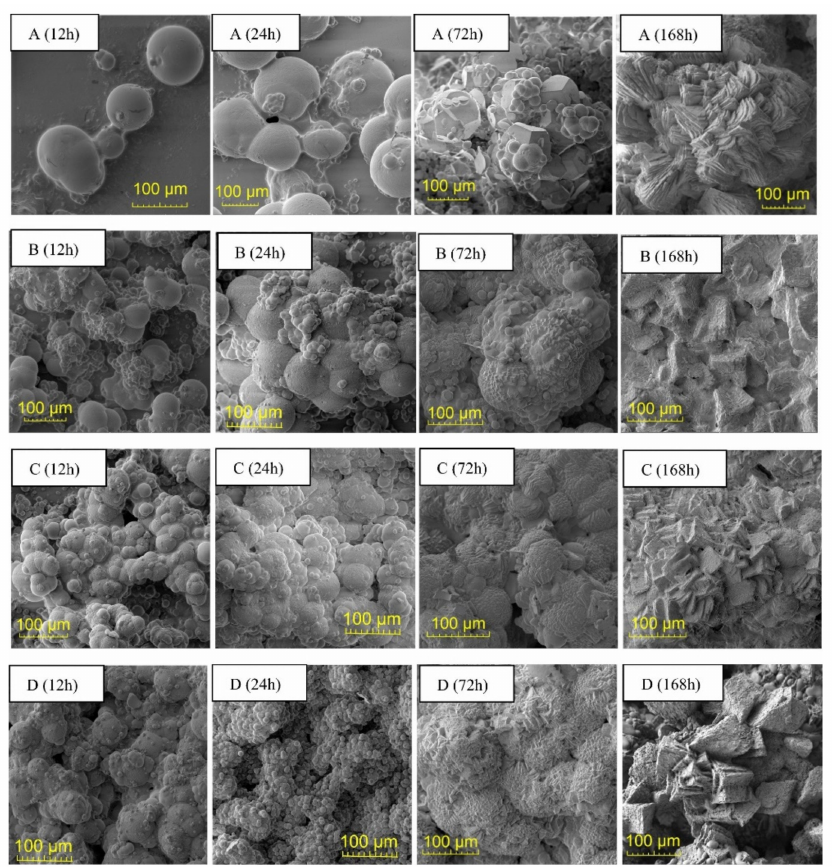
Figure 12. SEM images of CaCO 3 treated with different concentrations of bacterial solution. ( A ) OD 600 = 0.1; ( B ) OD 600 = 0.3; ( C ) OD6 00 = 0.6; ( D ) OD 600 = 1.0